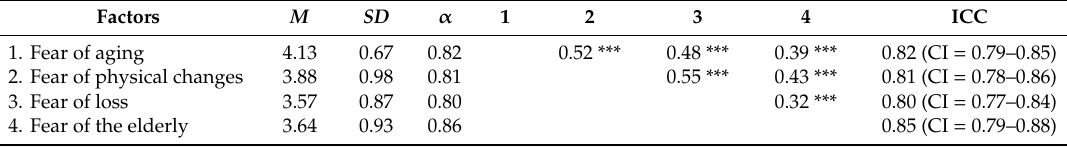
Table 3. Descriptive statistics, cronbach’s alpha, bivariate correlations and temporal stability